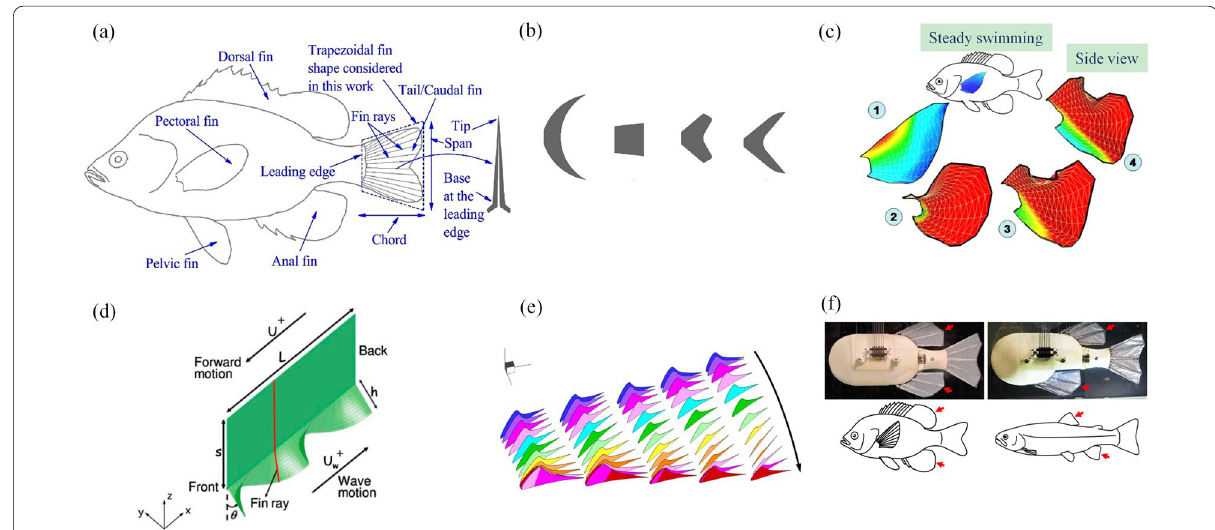
Figure 4 Foil research: ( a ) Different fins of fish [145]; ( b ) Different shapes of caudal fin [146]; ( c ) Conformations of pectoral fin at different time [147]; ( d ) 3D model of elongated fin [102]; ( e ) Finlet motion during the right-to-left stroke [148]; ( f ) The robotic swimmer with multi-fin [149]